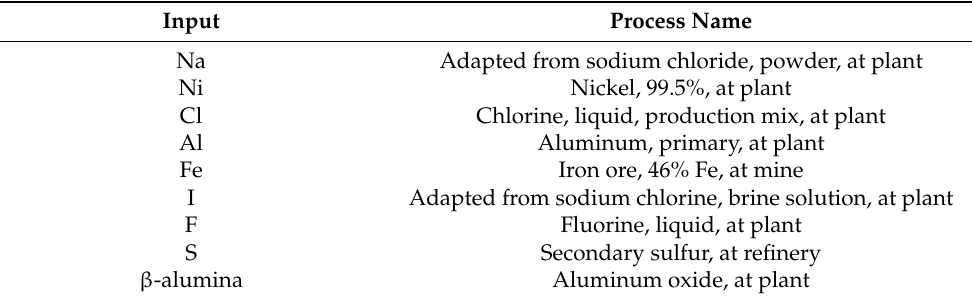
Table 3. Secondary data for modeling the background